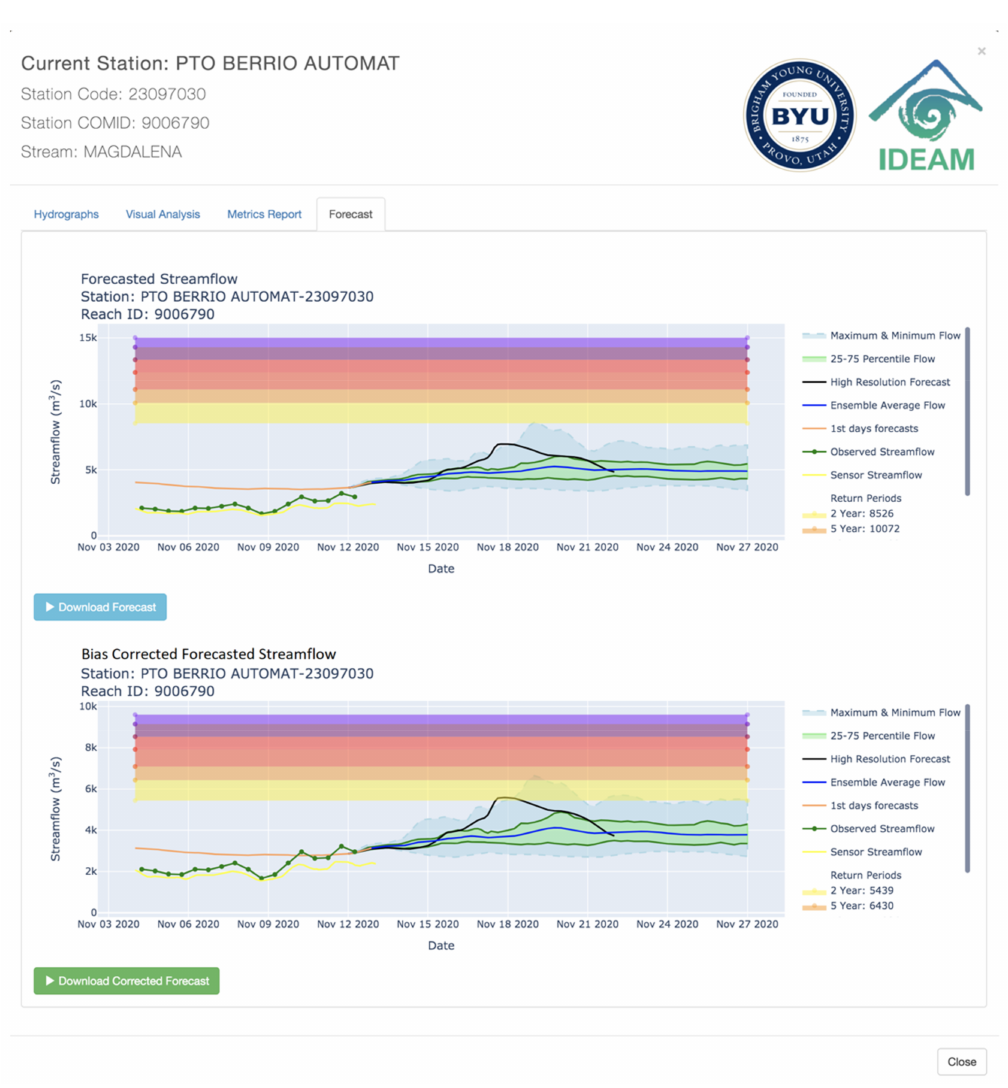
Figure 9. Forecast for the Puerto Berrio automatic station in the historical validation tool app for